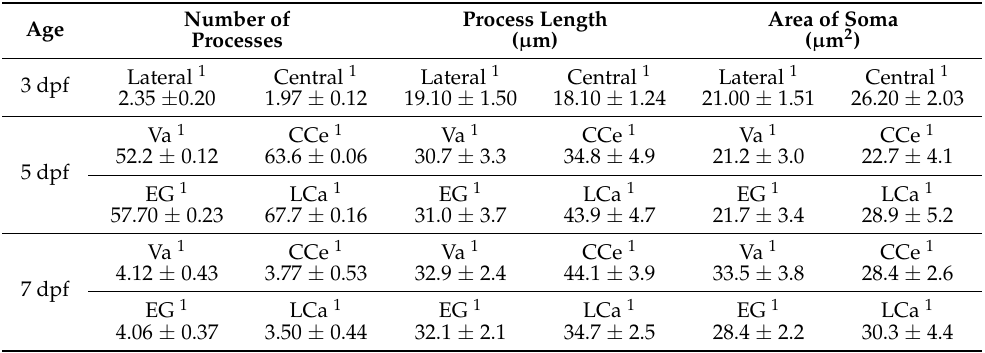
Table 2. Characteristics of radial glial cells in the